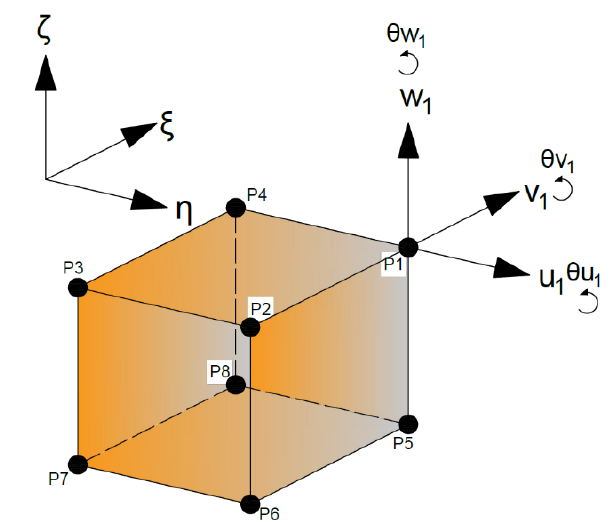
Figure 1. DOF for each edge of the